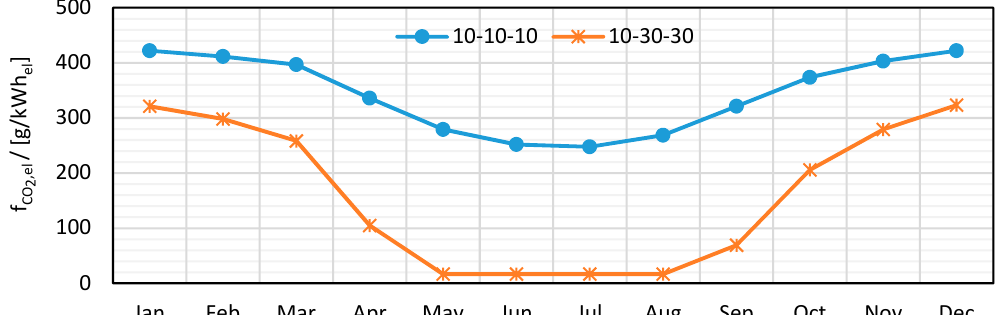
Figure 11. CO 2 conversion factors for four generic DH systems with different shares of bio-